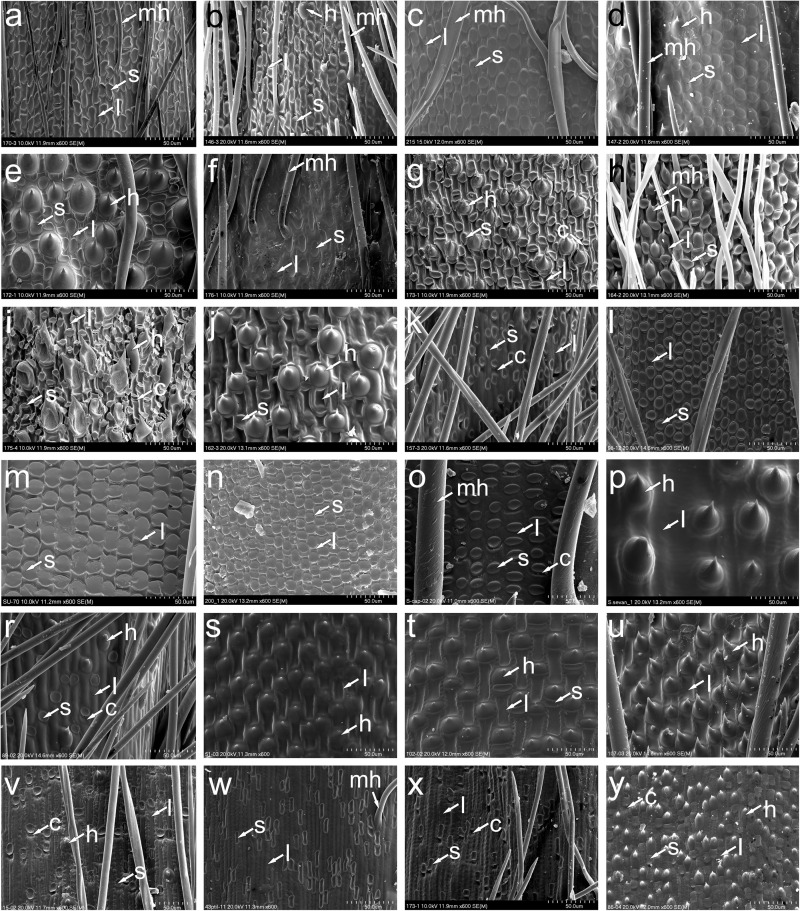
SEM morphology of lemma epidermal patterns of Austrostipa and exemplary other genera of Stipeae. (a)
A. breviglumis; (b)
A. platychaeta; (c)
A. rudis subsp. australis; (d)
A. pubinodis; (e)
A. pubescens; (f)
A. muelleri; (g)
A. ramosissima; (h)
A. verticillata; (i)
A. tuckeri; (j)
A. elegantissima; (k)
A. stipoides; (l)
Achnatherum calamagrostis; (m)
A. bromoides; (n)
A. paradoxum; (o)
Stipellula capensis; (p)
Nassella neesiana; (r)
Macrochloa tenacissima; (s)
Stipa tirsa; (t)
S. kirghisorum; (u)
S. drobovii; (v)
Neotrinia splendens; (w)
Ptilagrostis mongholica; (x)
P. concinna; (y)
Orthoraphium roylei. l, long cell (fundamental cell); s, silica cell; c, cork cell; h, hook; mh, macrohair. The list of specimens studied is presented in Supplementary Appendix 1.